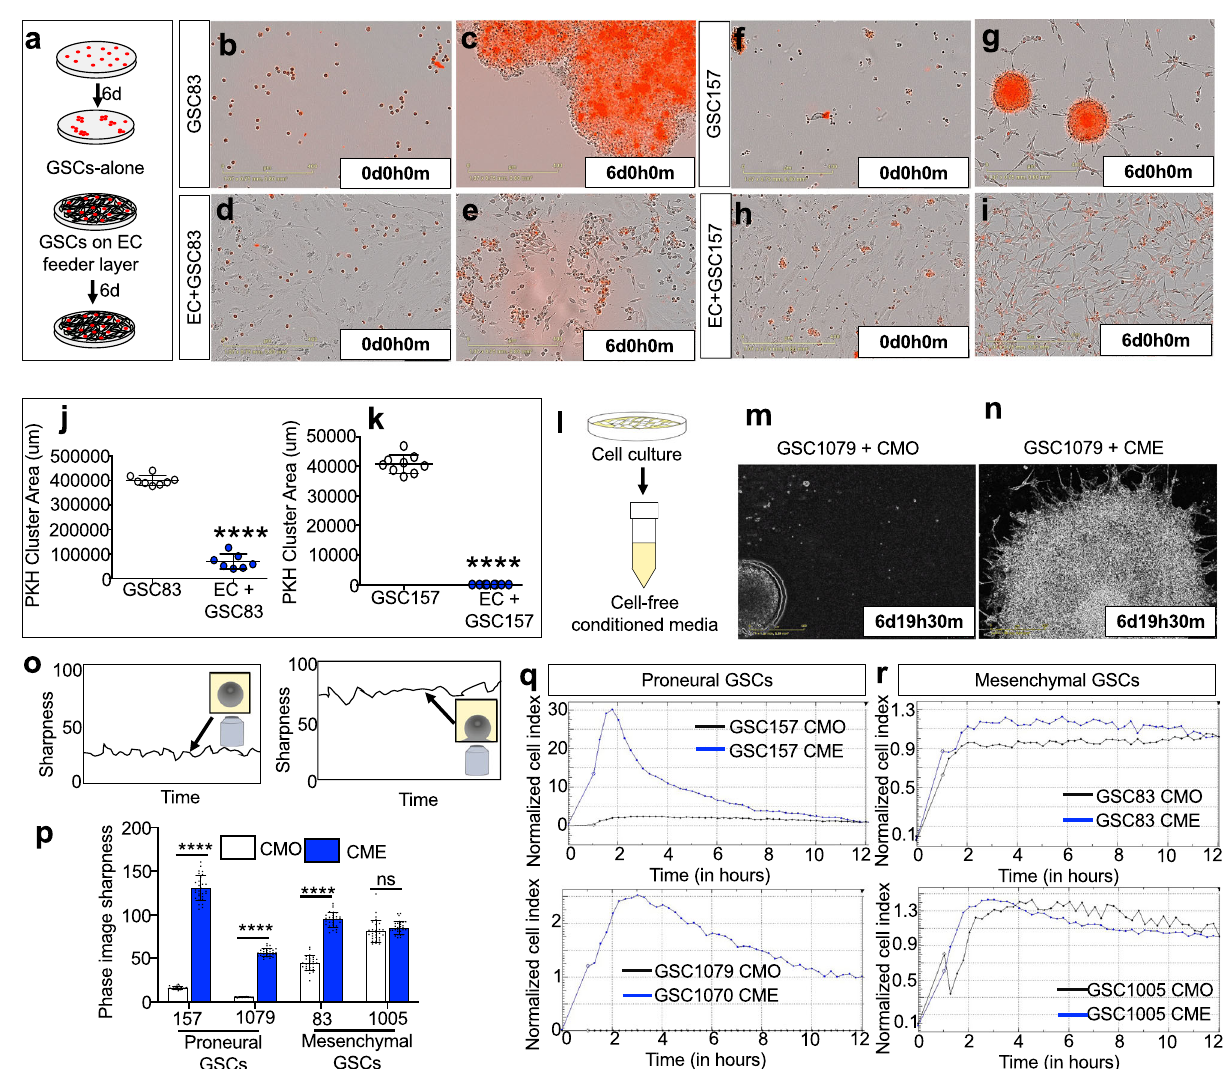
Fig. 2 | Paracrine disruption of glioma stem cell sphere formation by endo- thelialcells.a SchematicofculturingGSCsalone,orinco-culturewithHUVECsfor 6days.RedrepresentsGSCsandlightgreenrepresentsHUVECs. b , c Mesenchymal GSC83 stained with PKH26 (red) were cultured alone for 6 days and growth pat- ternswererecordedusingIncucyteimaging. d , e MesenchymalGSC83stainedwith PKH26 and co-cultured with unlabeled HUVECs for 6 days and recorded using Incucyte. f , g Proneural GSC157 stained with PKH26 and cultured for 6 days (Incucyte). h , i Proneural GSC157 stained with PKH26 and cultured with